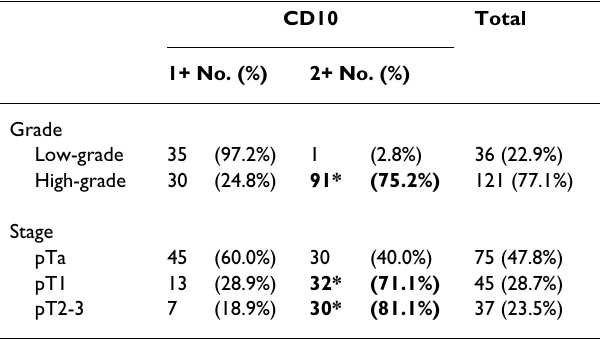
Table 2: CD10 staining scores in cases with positive expression according to the histologic grade and pathologic stage CD10